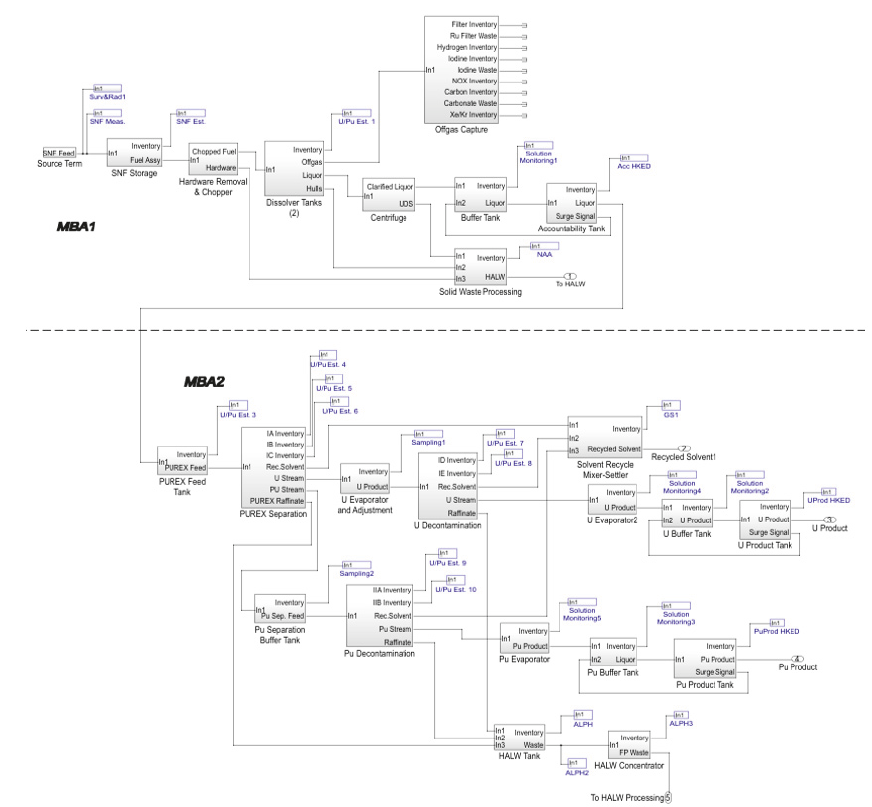
Figure 1: SSPM for a PUREX reprocessing